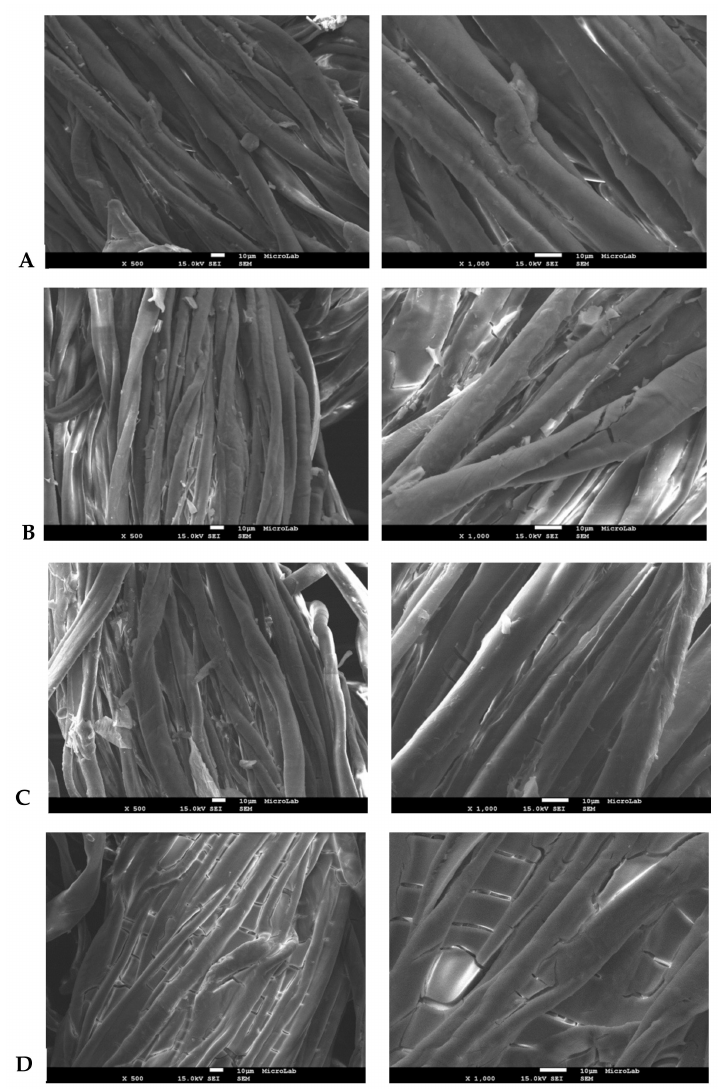
Figure 7. Cotton matrix coated with a-TiO 2 film, as follows: after 1 min immersion ( A -without cure; B -cured) and after 30 min immersion ( C -without cure; D